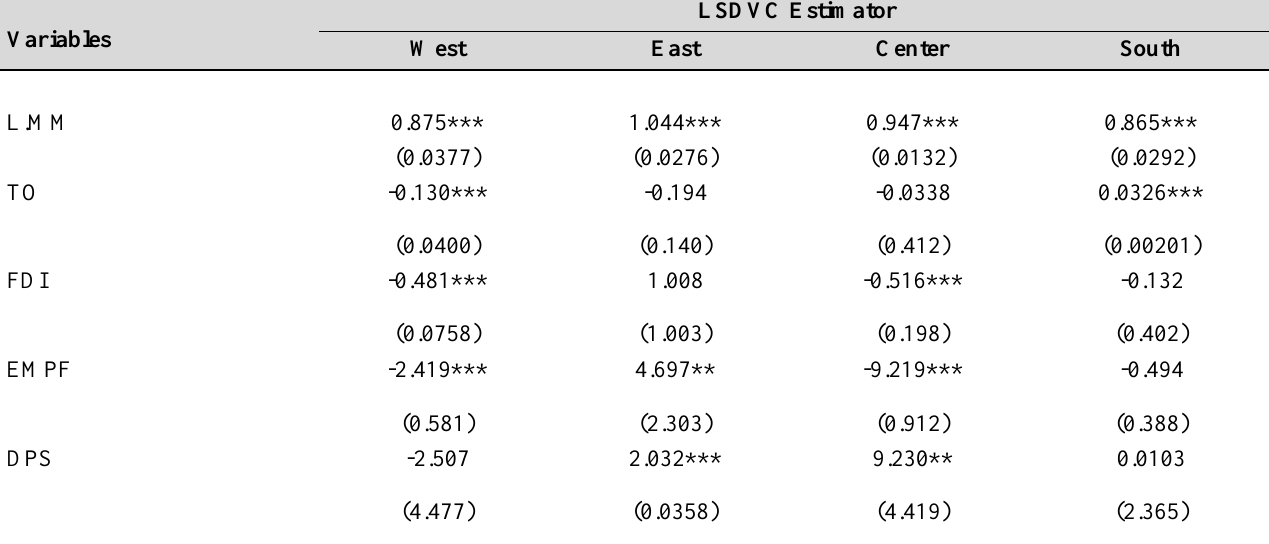
Results of estimates of the effect of globalization and women's employability on maternal health in Sub-Saharan